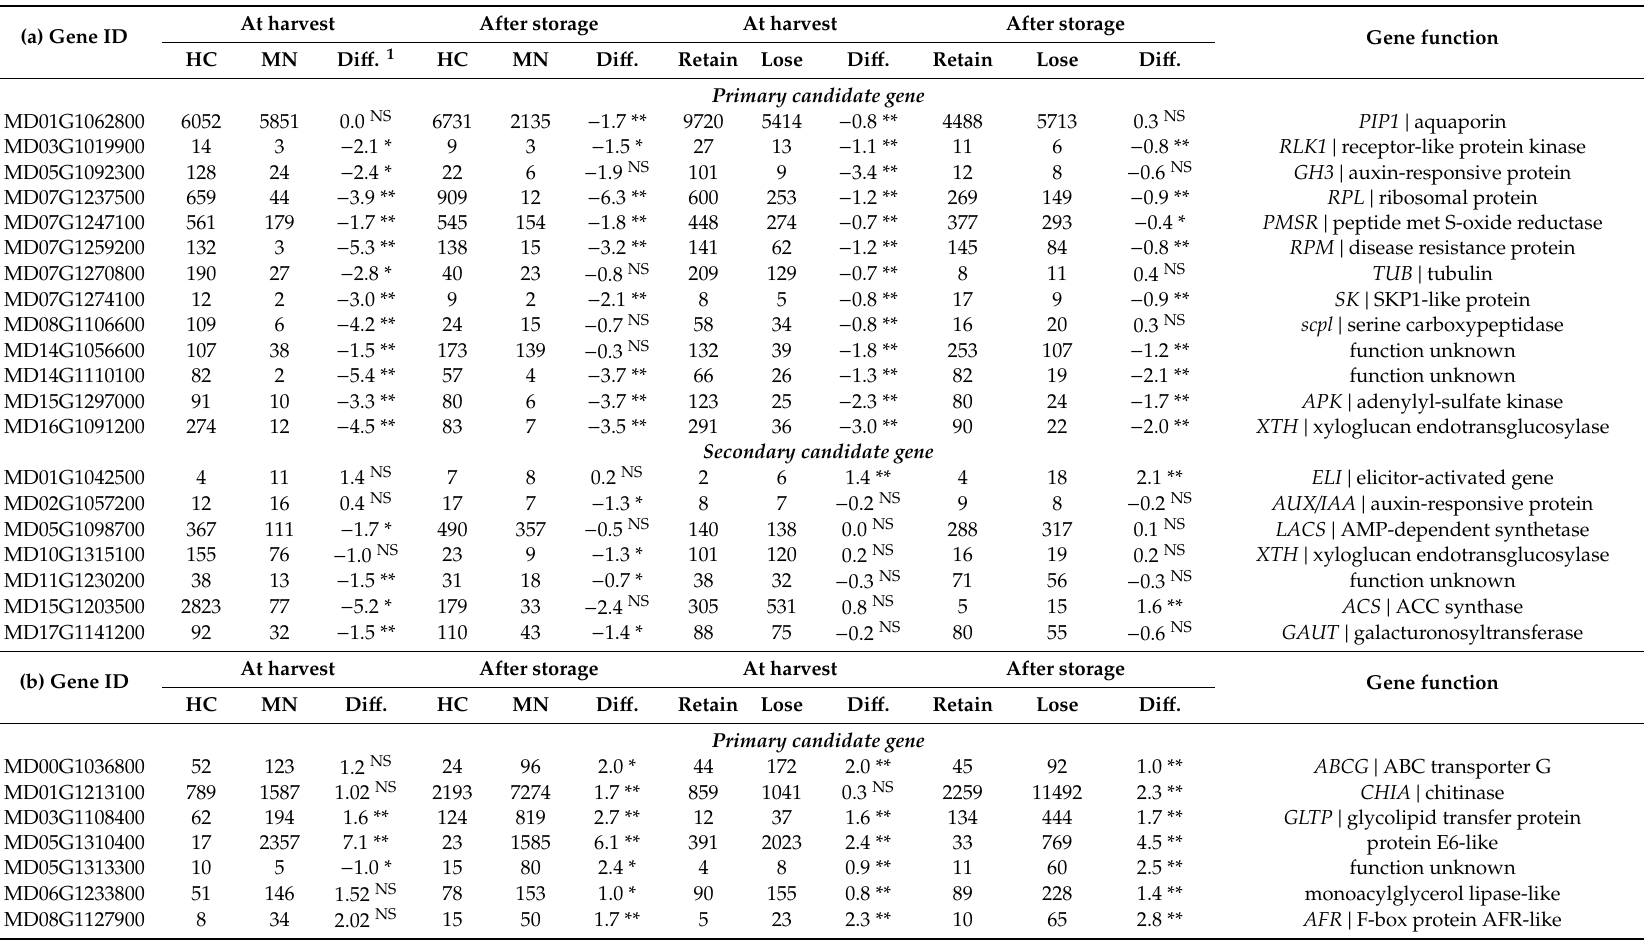
Table 2. The numbers of gene counts in the fruit samples at harvest and after 8-week cold storage measured using NanoString nCounter ® technology. ( a ) Genes that were highly expressed in ’Honeycrisp’ (HC) and / or the “Retain” group fruit, and ( b ) genes that were highly expressed in MN1764 (MN) and / or “Lose” group fruit. The genes that were di ff erentially expressed in both parent and progeny samples were the primary candidates, while the genes that were only di ff erentially expressed in the parent or the progeny samples were the secondary